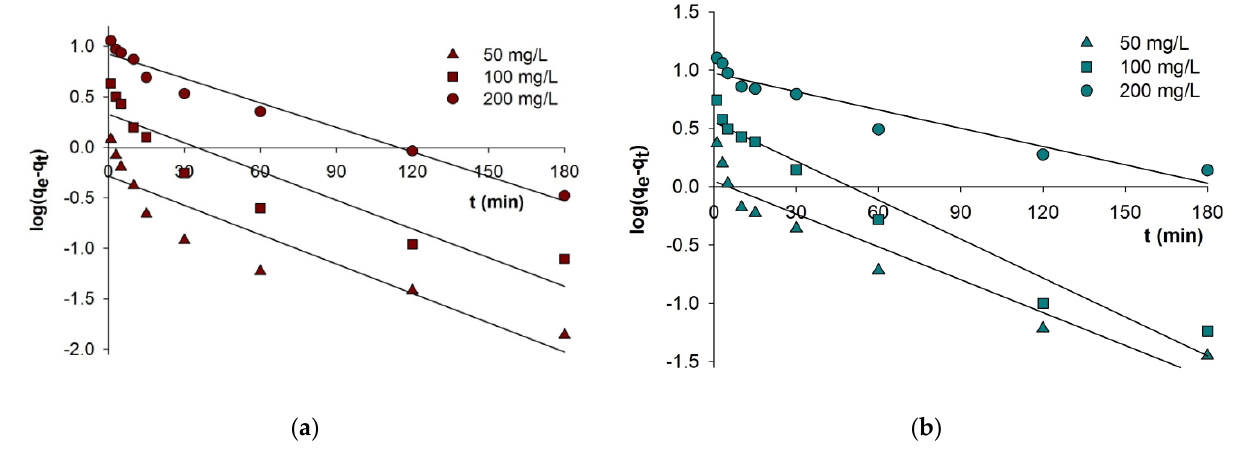
Figure 2. Pseudo-first order kinetic model for BB3 adsorption on ( a ) sawdust and ( b ) Cladium mariscus. Table 2. Pseudo-first order, pseudo-second order, and intraparticle diffusion kinetic parameters for adsorption of BB3 onto sawdust and Cladium mariscus saw-sedge.